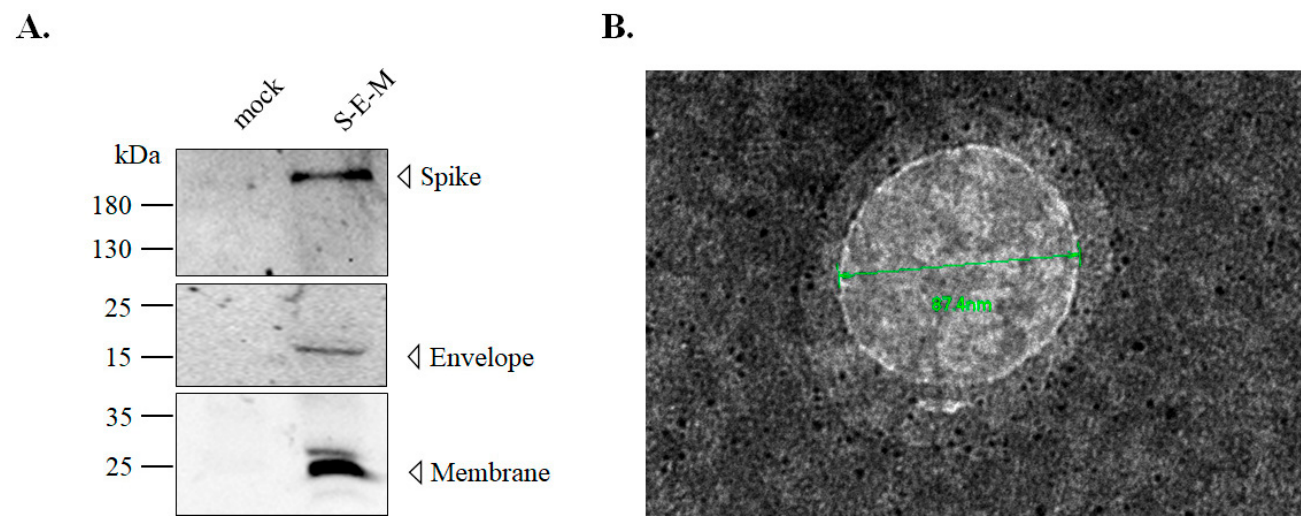
Figure 3. Isolation of SCoV2-SEM VLPs from the culture medium of S-E-M-expressing cells. ( A ) Western blotting ascertained the presence of recombinant S, E, and M proteins in the culture media of S-E-M-expressing cells, but not mock cells. ( B ) The negative-stain TEM image illustrated that the size of SCoV2-SEM VLPs was around 87 nm.